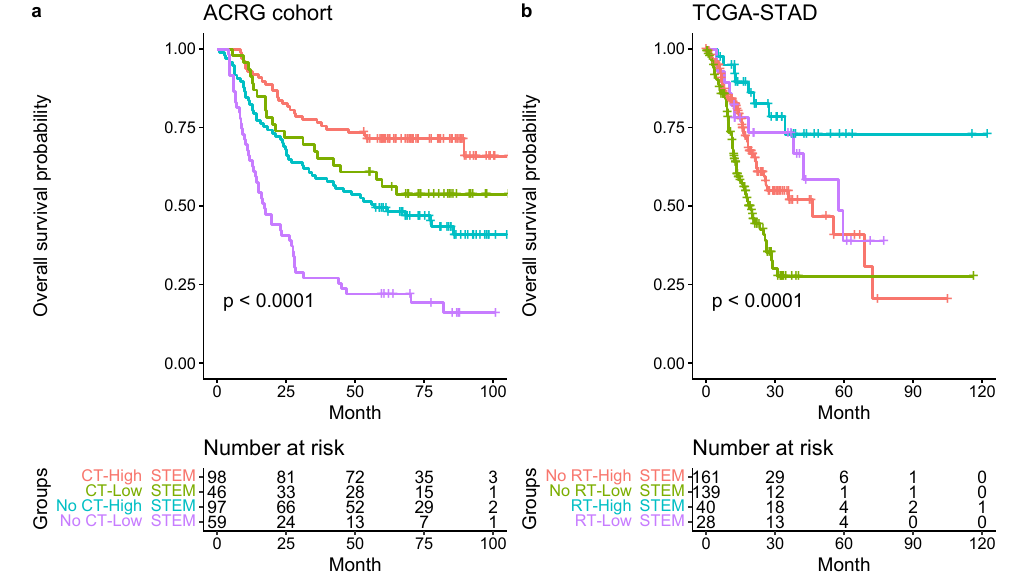
Figure 14. ( a ) Kaplan–Meier survival curves for the four groups (including chemotherapy-high STEM score, chemotherapy-low STEM score, no chemotherapy-high STEM score, and no chemotherapy-low STEM score) in the ACRG cohort. Significance test p value is shown in the lower left. ( b ) Kaplan– Meier survival curves for the four groups (including radiation therapy-high STEM score, radiation therapy-low STEM score, no radiation therapy-high STEM score, and no radiation therapy-low STEM score) in the TCGA-STAD